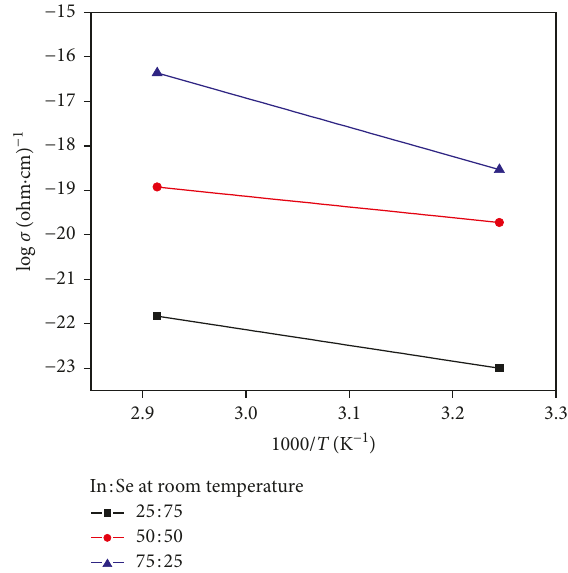
Figure 6: Variation in logarithm of electrical conductivity with temperature.